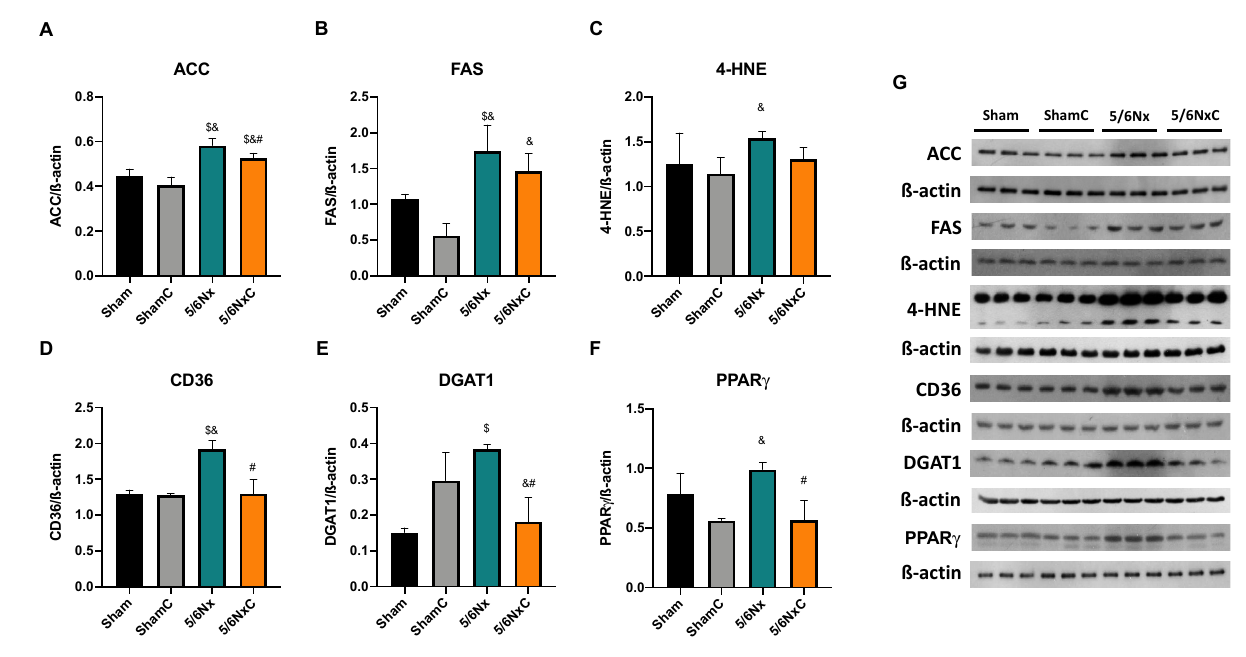
Figure 7. Liver lipid synthesis and storage-related proteins abundance in the four groups of rats studied: Sham, Sham + curcumin (ShamC), five-sixths nephrectomy (5/6Nx), and 5/6Nx + curcumin (5/6NxC). ( A ) Acetyl CoA carboxylase (ACC), ( B ) Fatty acid synthase (FAS), ( C ) 4-hydroxynonenal (4-HNE), ( D ) Fatty acid receptor cluster of differentiation 36 (CD36), ( E ) Diacylglycerol acyl trans- ferase 1 (DGAT1), ( F ) Peroxisome proliferator-activated receptor gamma (PPAR γ ), and ( G ) repre- sentative images of western blot. β -actin was used as a loading control. One-way analysis of vari- ance (ANOVA), post hoc Fisher´s Least significant difference (LSD), Mean ± SD, n = 3. $ p < 0.05 vs. Sham, & p < 0.05 vs. ShamC, # p < 0.05 vs. 5/6Nx.